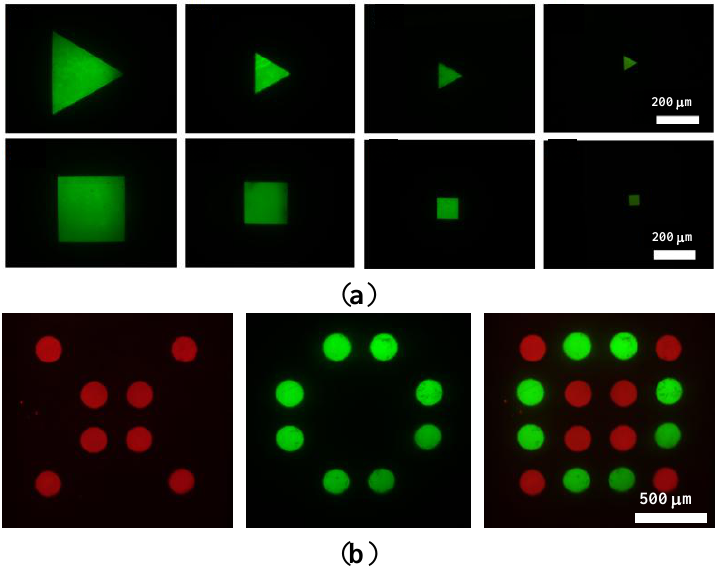
Figure 4. ( a ) Images of chitosan membranes with triangular and square shapes with different dimensions ranging from 50  m to 300  m. ( b ) The images of multiplexed micropatterning of chitosan membranes created by performing a light-addressed electrodeposition using two different illumination light patterns in sequence. The rightmost image shows the fluorescence micrograph of an assembled 4 × 4 microarray of chitosan membranes with a specific